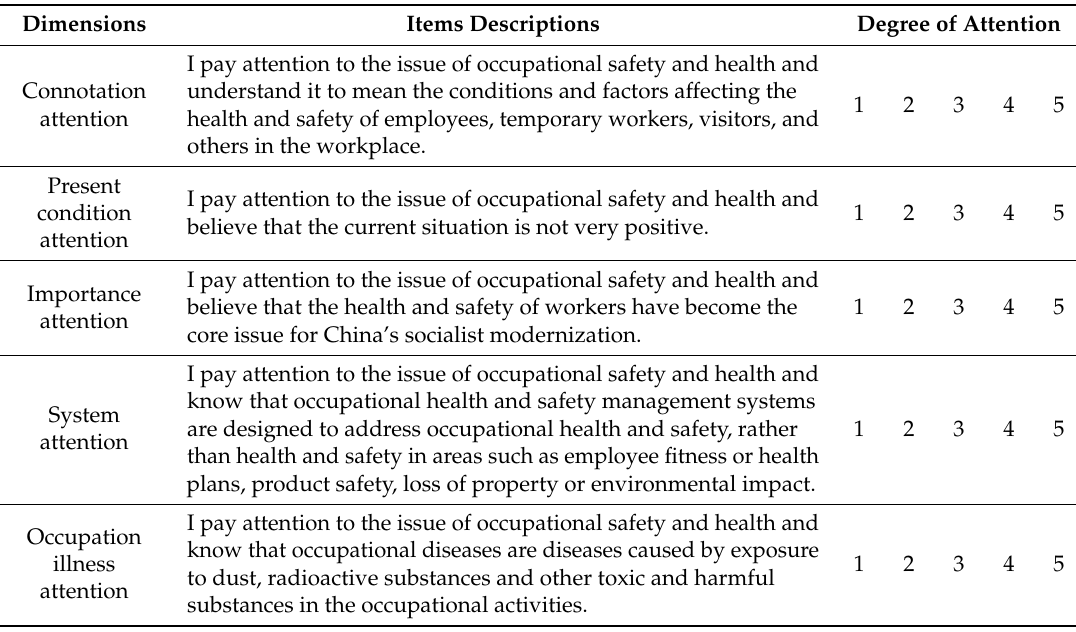
Table 1. Occupational safety and health attention questionnaire